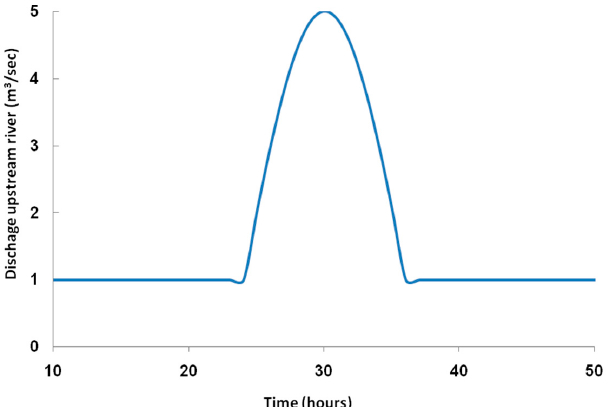
Figure 11. Analytical hydrograph formulated as a half sine wave introduced in hydrodynamic surface water model.